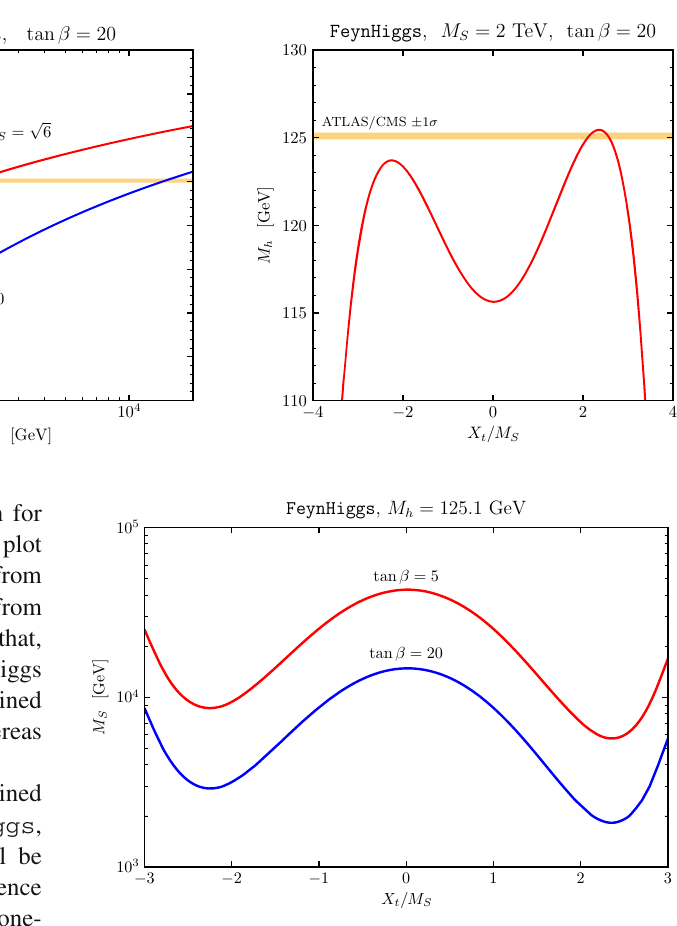
Fig. 2 Values of the SUSY mass parameter M S and of the stop mixing parameter X t (normalized to M S ) that lead to the prediction M h = 125 . 1 GeV, in a simplified MSSM scenario with degenerate SUSY masses, for tan β = 20 (blue) or tan β = 5 (red)